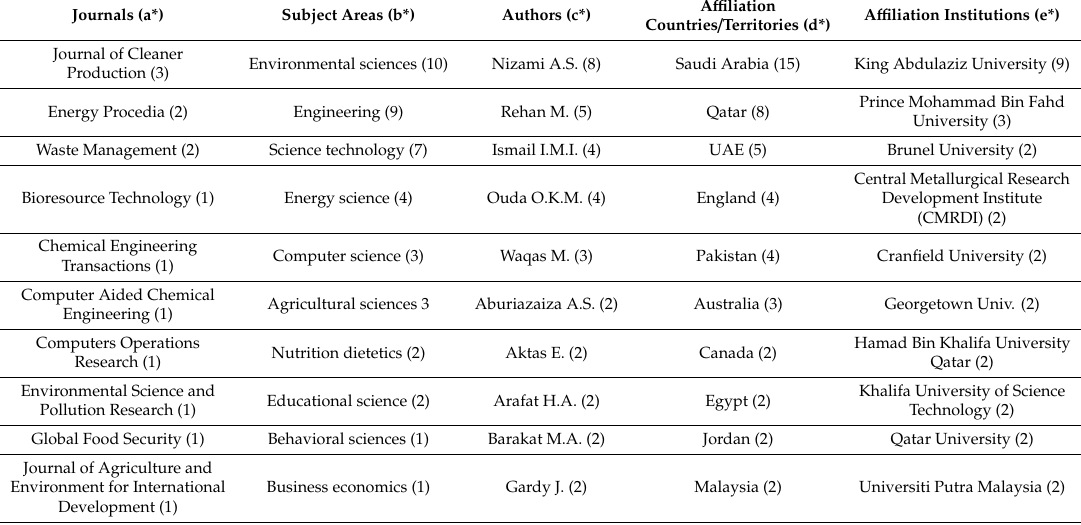
Table 4. Metrics of research on food waste in the GCC: top ten subject areas, journals, authors, a ffi liation countries, and a ffi liation